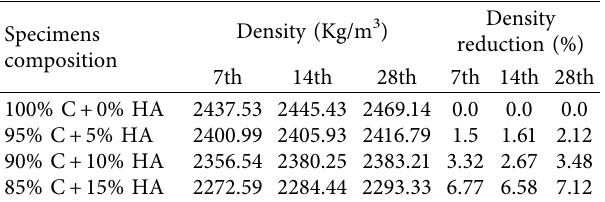
Figure 7: Compaction factor test result. Table 9: Density of the cubes